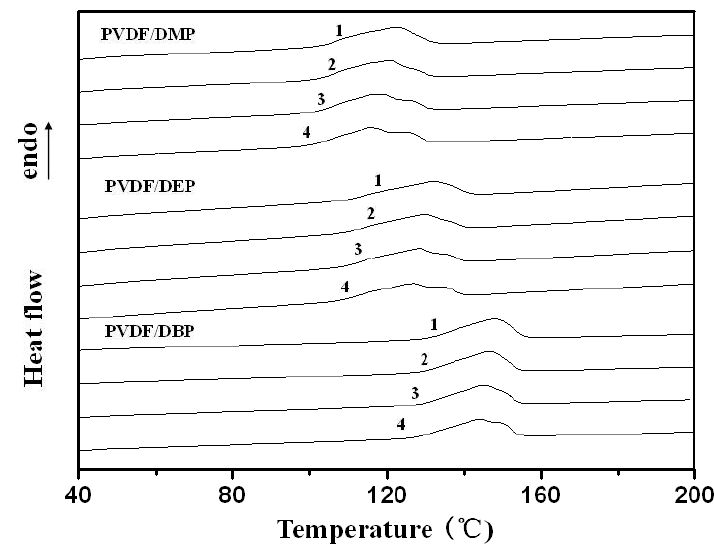
Figure 2. DSC scans showing the melting traces of PVDF/dialkyl phthalate blends at the rate of 10 °C/min.